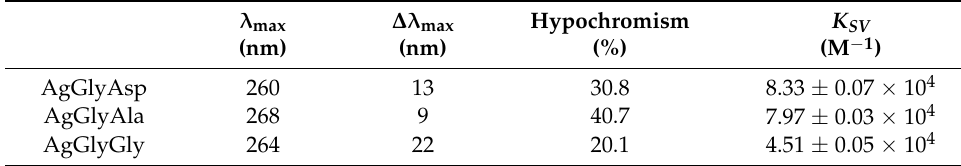
Figure 8. Absorption spectra of AgGlyAsp in 0.01 M Tris buffer with increasing concentration of CT DNA. The black line corresponds to the spectrum of the free complex. Table 6. Spectral and binding characteristics of Ag(I)